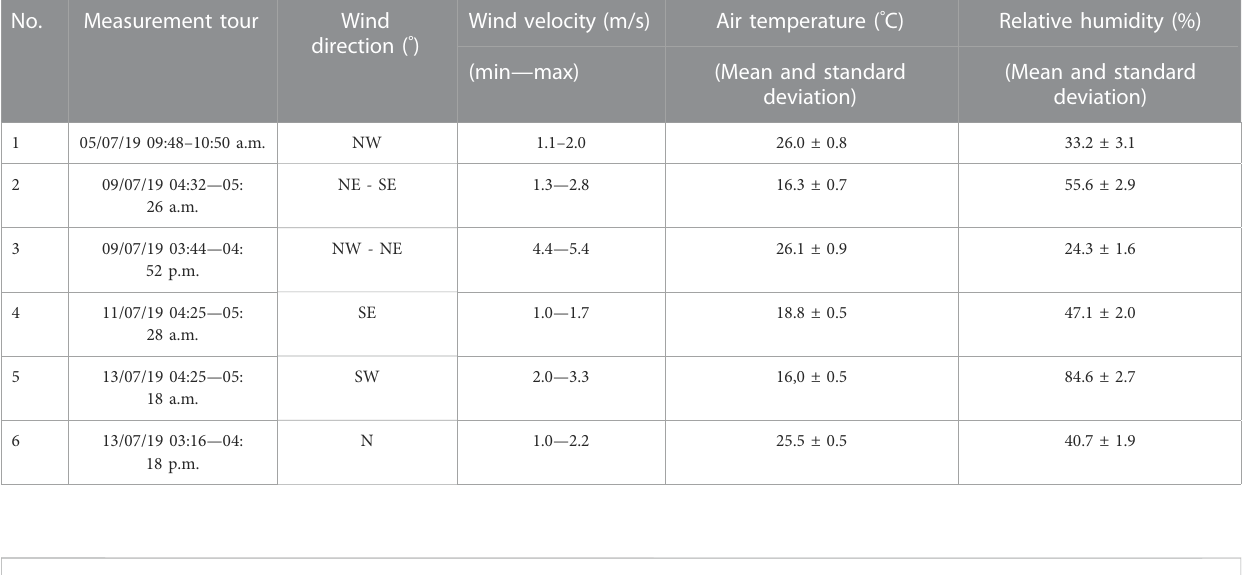
TABLE 2 Meteorological parameters during the bike tours.